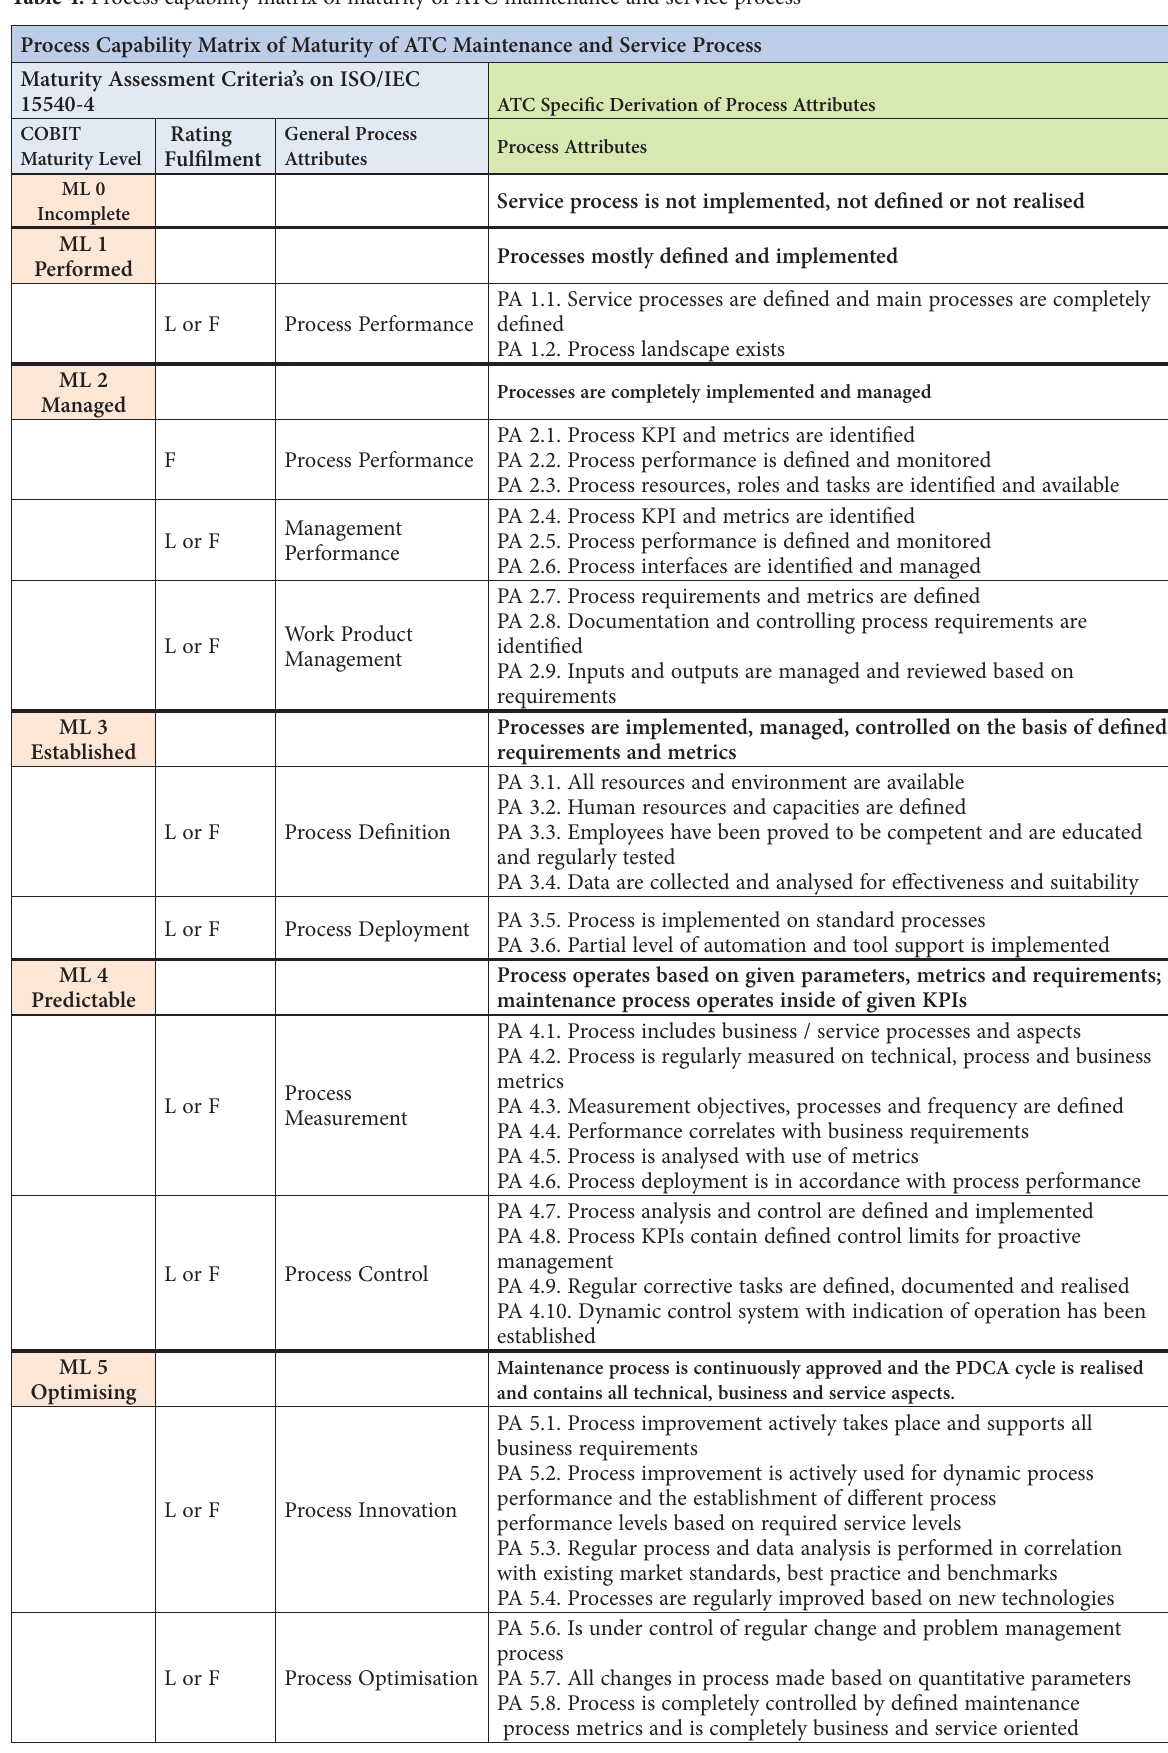
Table 4. Process capability matrix of maturity of ATC maintenance and service process Process Capability Matrix of Maturity of ATC Maintenance and Service Process Maturity Assessment Criteria’s on ISO/IEC